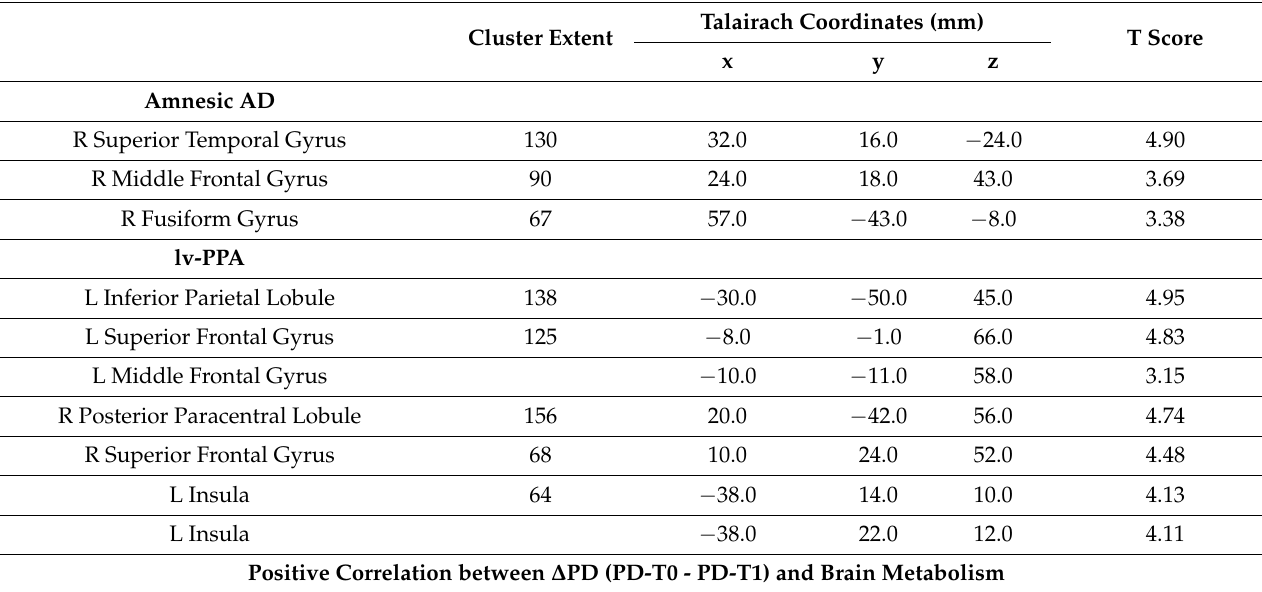
Table 4. Correlation between changes in empathy over time and cerebral hypometabolism in in logopenic primary progressive aphasia and amnesic Alzheimer’s disease patients at 18F-FDG-PET SPM